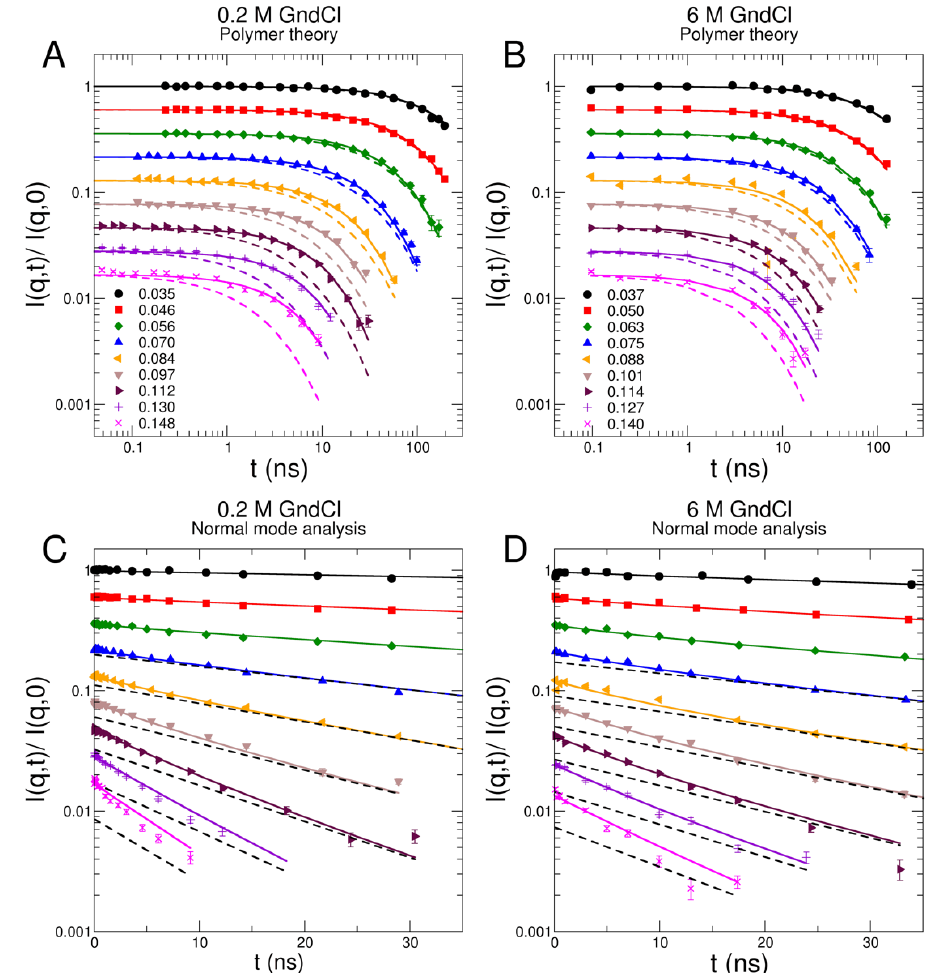
Figure 4. NSE data of MBP in representative GndCl concentrations. ( A , C ) MBP in D 2 O buffer solution with 0.2 M GndCl, ( B , D ) structurally expanded MBP in 6 M GndCl. ( A , B ) NSE spectra fitted with Zimm (dashed lines) and ZIF (solid lines) polymer models. Experimental data are represented by symbols. The scattering-vectors of the NSE spectra are given in units of Å − 1 in the legends. ( C , D ) NSE spectra interpreted using normal mode analysis (solid lines) of the course-grained structural ensemble shown in Figure 2C. The black dashed lines indicate global translational and rotational diffusion of the structural models. All spectra start at unity. They are shifted by a factor of 0.8 for clarity.